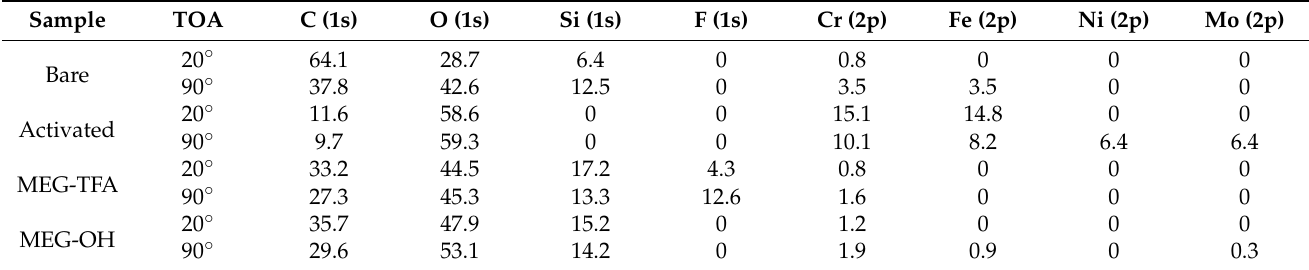
Table 2. XPS relative atomic percentages for untreated (bare), oxidized (activated), MEG-TFA-modified (MEG-TFA) and MEG-OH-modified (MEG-OH) stainless steel at 20- and 90-degree take-off angles (TOA).